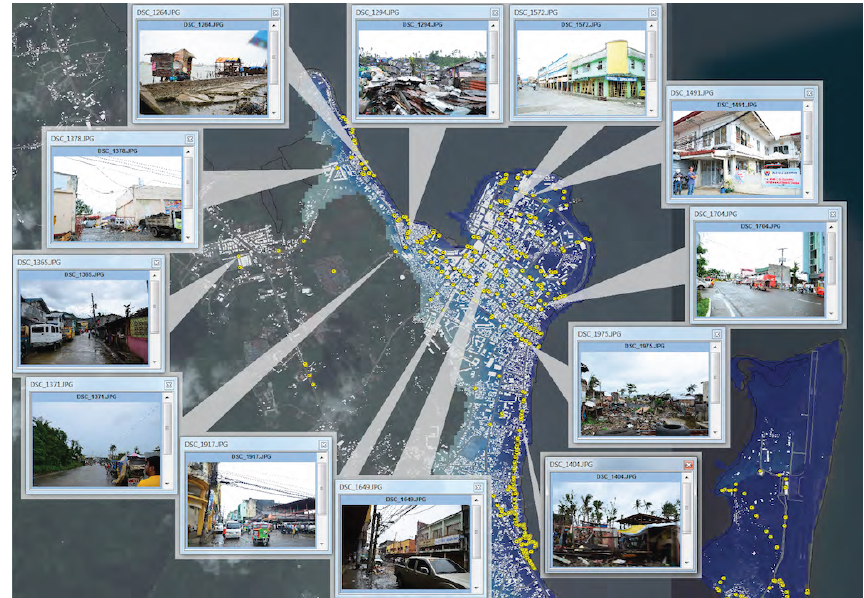
Figure 4. Photos taken during the field survey at the areas assessed through visual inspection of satellite images. The damage conditions and distribution confirm the interpretation that higher damages existed to the north and south of the downtown area in Tacloban city, the Philippines.